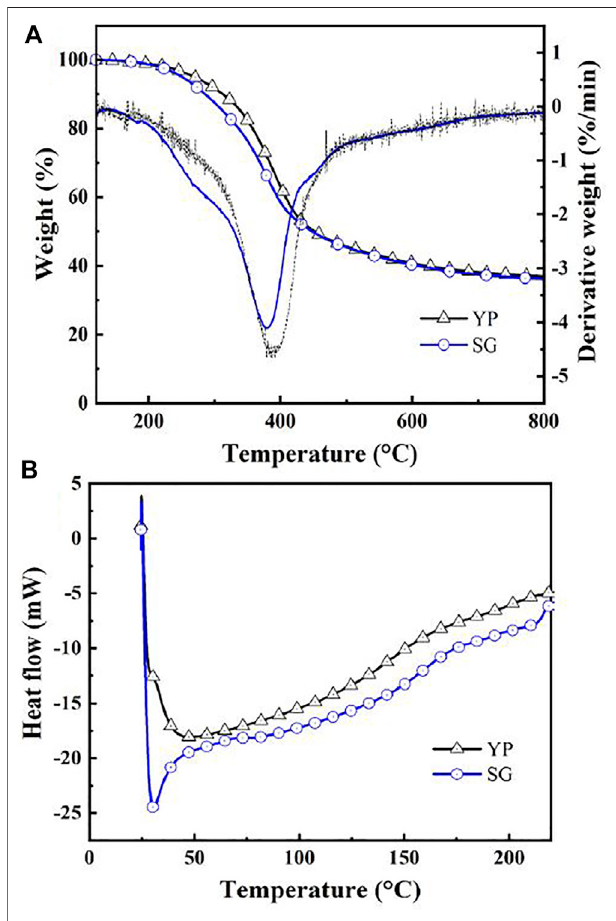
FIGURE4|(A) TGAand (B) DSCcurvesofYPandSGligninprecursors.